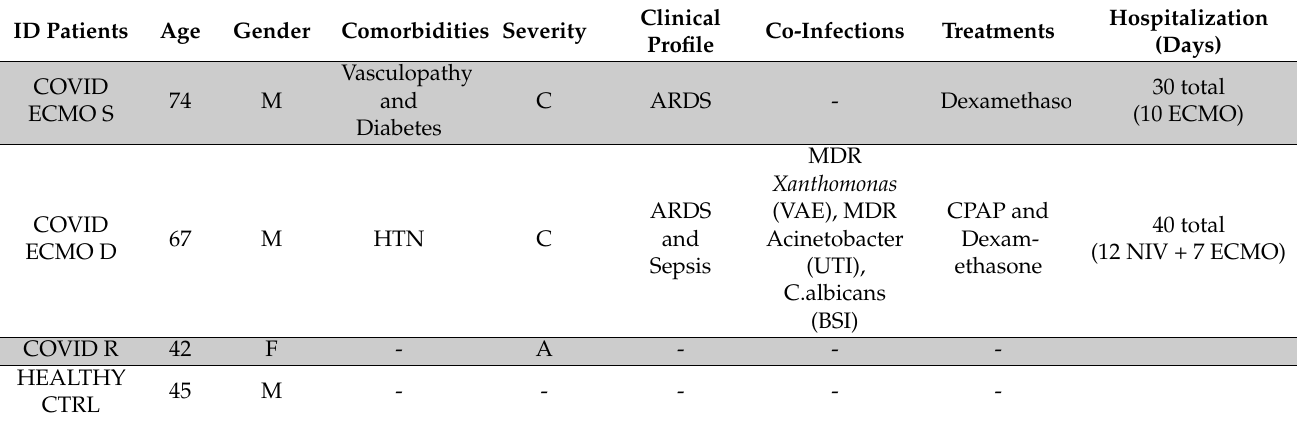
Table 1. Characteristics of patients and